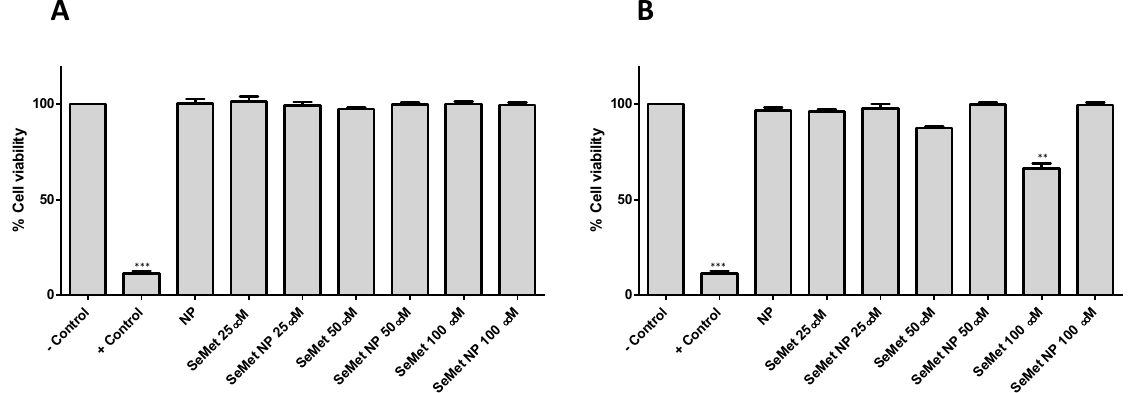
Figure 3. MTS assessment of SeMet, unloaded NPs and SeMet NPs exposed for ( A ) 4 h in Caco-2 cells and ( B ) 72 h in HepG2 cells. Triton ® X-100 (0.05%) was used as positive control and no treatment as negative control (untreated). One-Way ANOVA with Dunnett’s post-test *** p < 0.001, ** p < 0.01. Each value presented was normalised against untreated control and calculated from three separate experiments ( n = 3), each of which included six replicates.